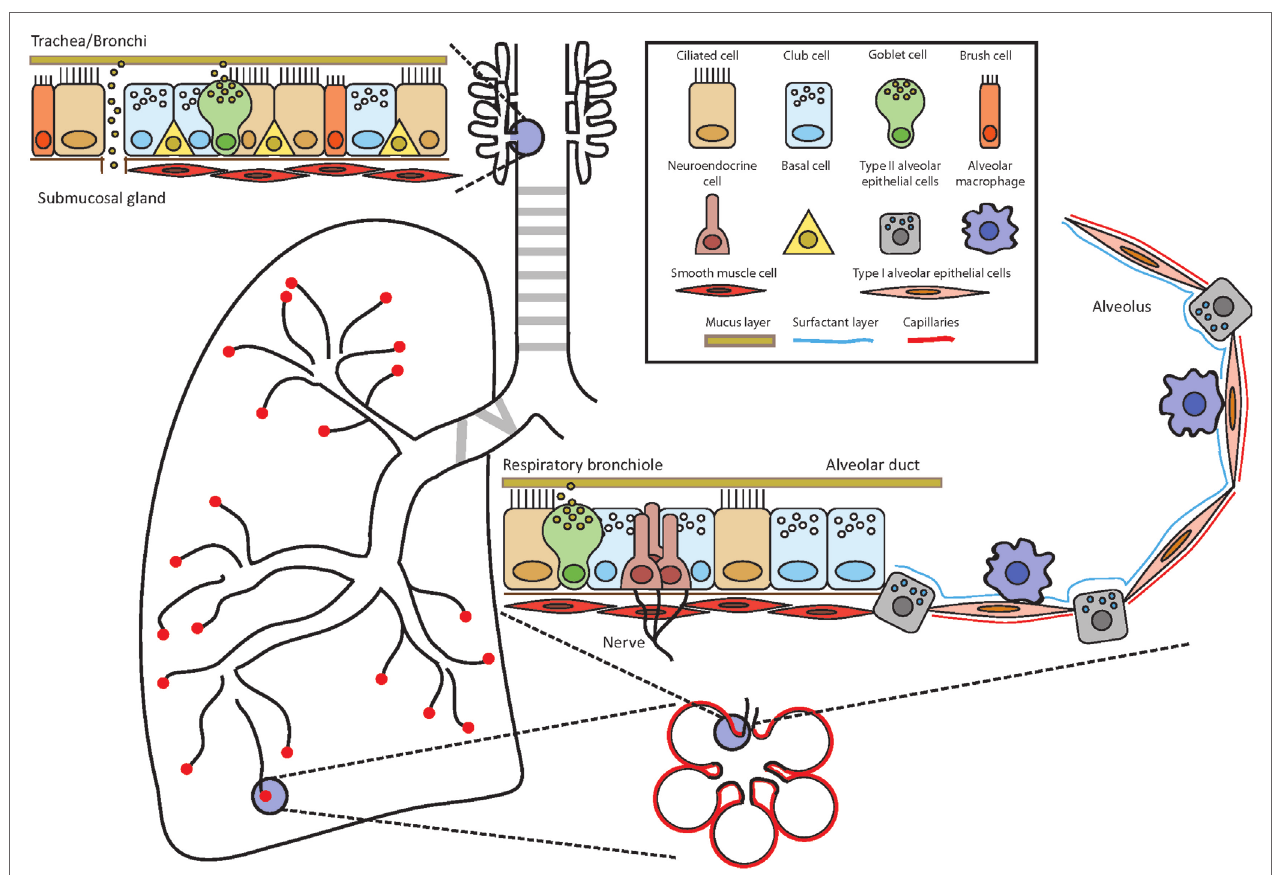
FiGURe 1 | Anatomy of the airways. Throughout the airways, the cell composition of the epithelium changes to ensure optimal and efficient gas exchange as well as maintenance of lung integrity and defense against potential pathogens and allergens. Depending on the location, the epithelium is composed of several different cell types such as ciliated cells, club cells, brush cells, goblet cells, airway smooth muscle cells, neuroendocrine cells, type I and type II alveolar epithelial cells, and alveolar macrophages. Basal cells have the potential to differentiate into several lineages and serve as stem